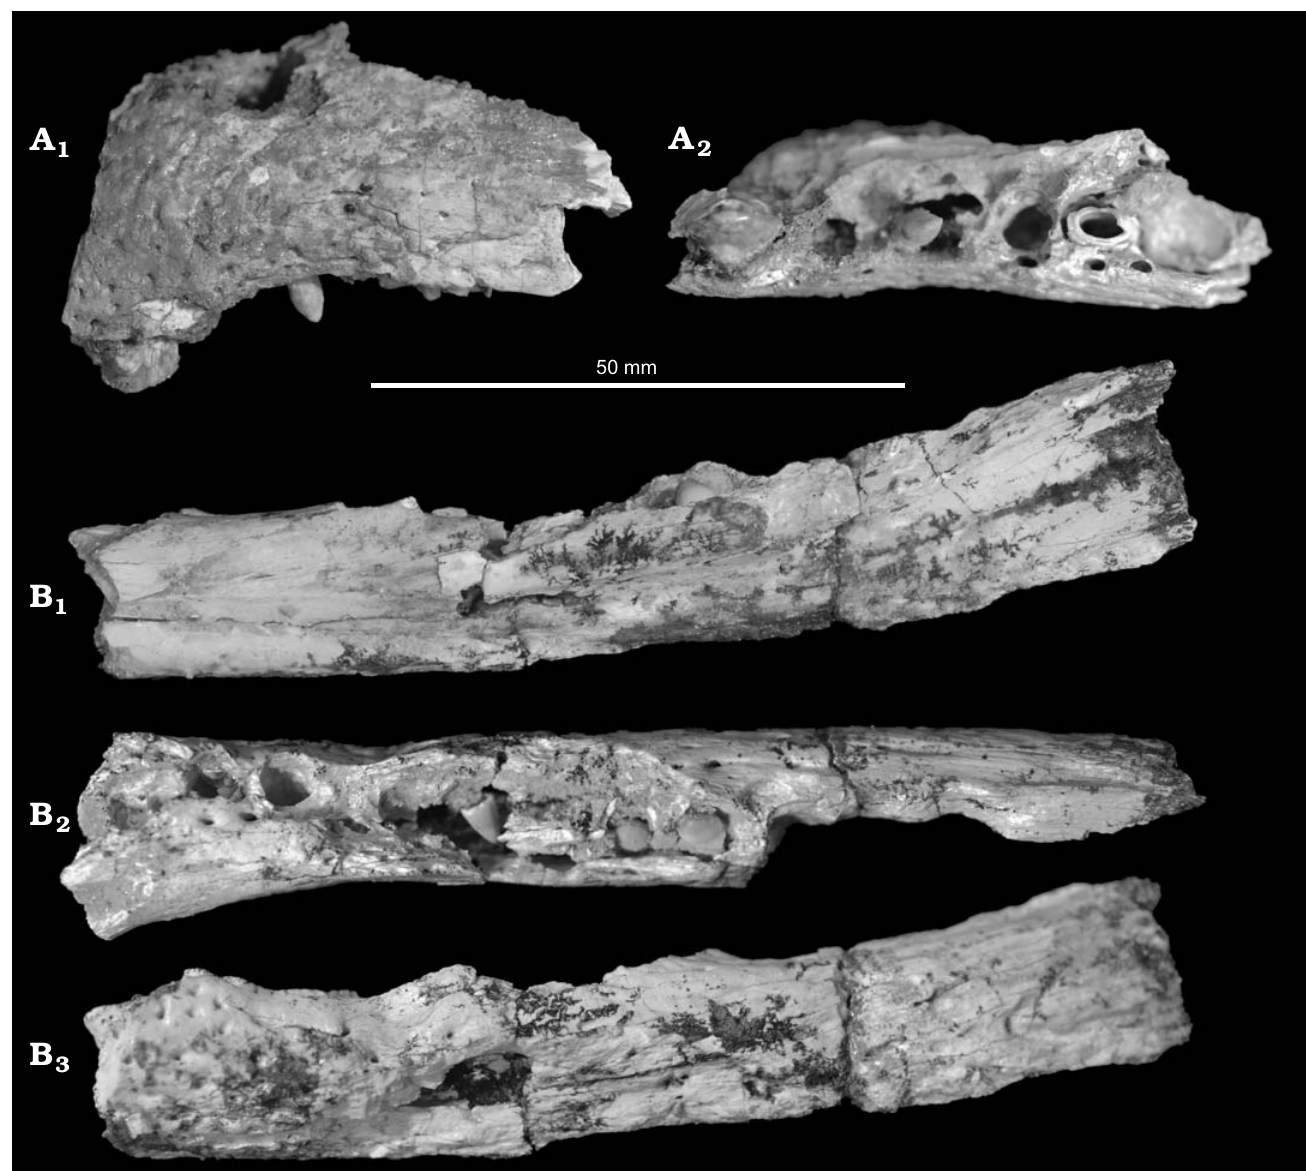
Fig. 1. Rostra of mekosuchine crocodile Mekosuchus whitehunterensis Willis, 1997; White Hunter Site, Riversleigh World Heritage Area, northwestern Queensland, Australia; late Oligocene. A . Left maxilla (QM F56046) in buccal (A 1 ) and ventral (A 2 ) views. B . Left dentary (QM F 56047) in lingual (B 1 ), dorsal (B 2 ), and buccal (B 3 )